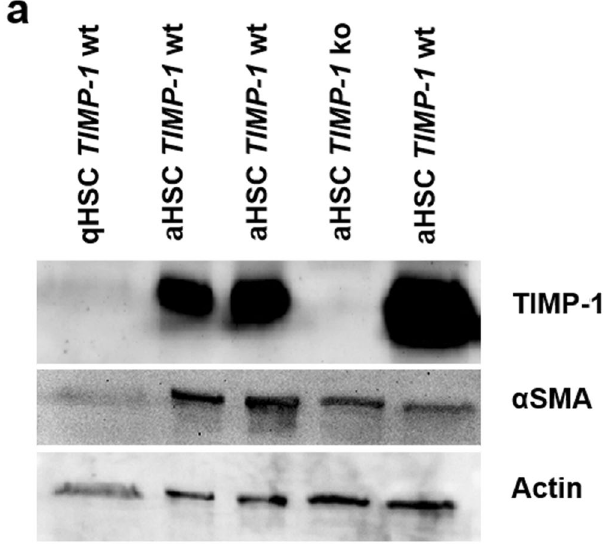
Figure 1. Confirmation of TIMP-1 protein deletion in hepatic stellate cells from TIMP-1 ko mice . ( a ) Cropped Western Blots showing no TIMP-1 protein in quiescent stellate cell (qHSC) lysates and activated stellate cells (aHSC) isolated from TIMP-1 ko mice, whereas activated stellate cells from TIMP-1 wt livers show elevated TIMP-1 protein level. Activation status of hepatic stellate cells is indicated by α SMA expression. Each lane represents lysed HSCs pooled after isolation from 3 mice. Full-length blots are presented in Supplementary Figure